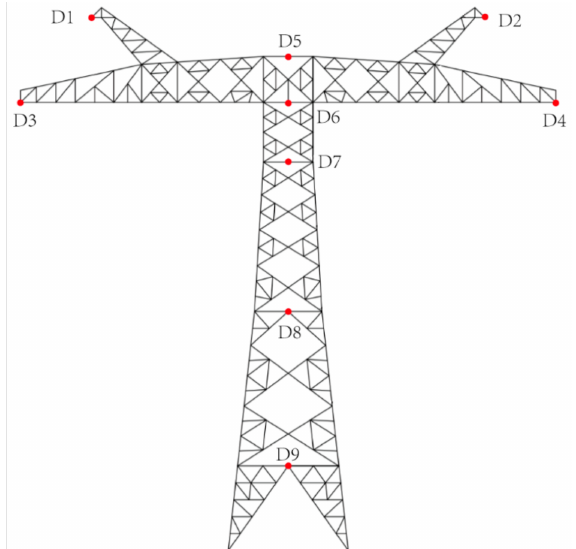
Figure 3. Displacement observation point layout.